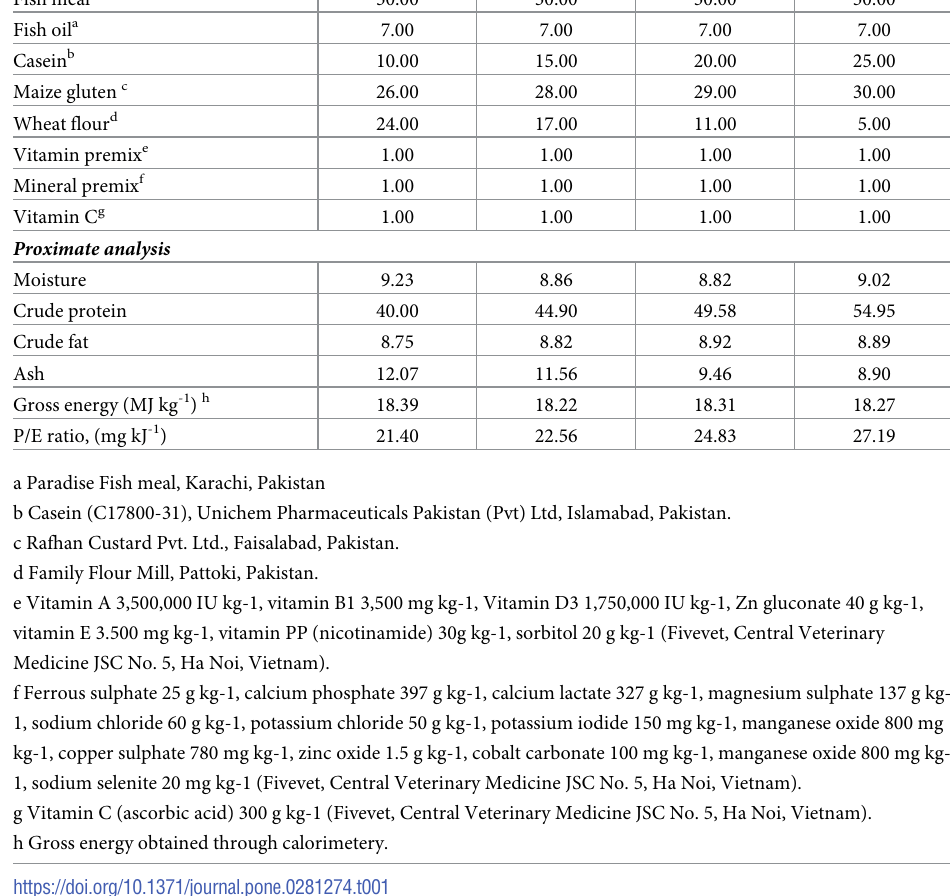
Table 1. Test diet formulation and proximate composition (%, dry weight). Diet formulation P40